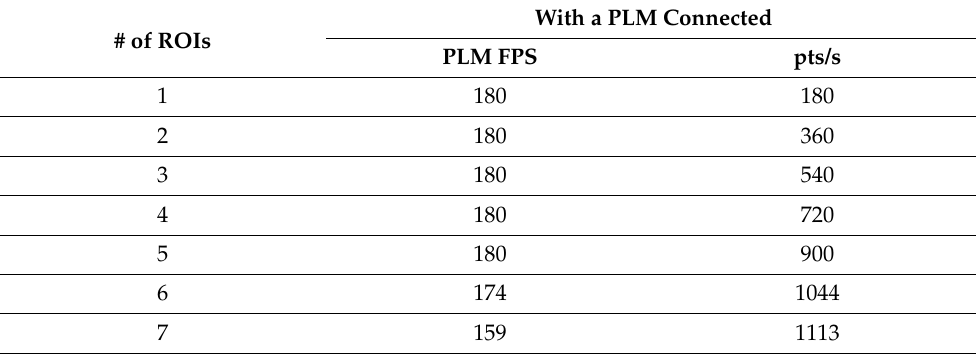
Table 3. Experimental beam-steering speed in the GPU-RGB mode with a PLM connected to a laptop. With a PLM Connected # of ROIs PLM